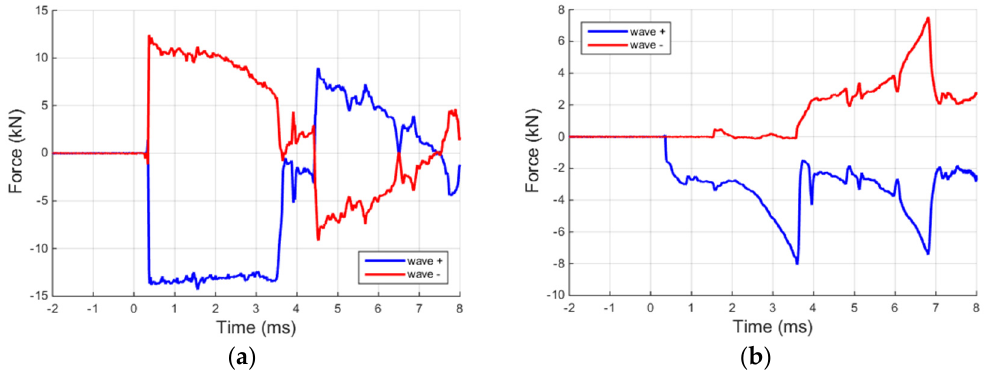
Figure 8. Waves propagating in the ( a ) input; and ( b ) output bars, reconstructed at the interfaces with the specimen.